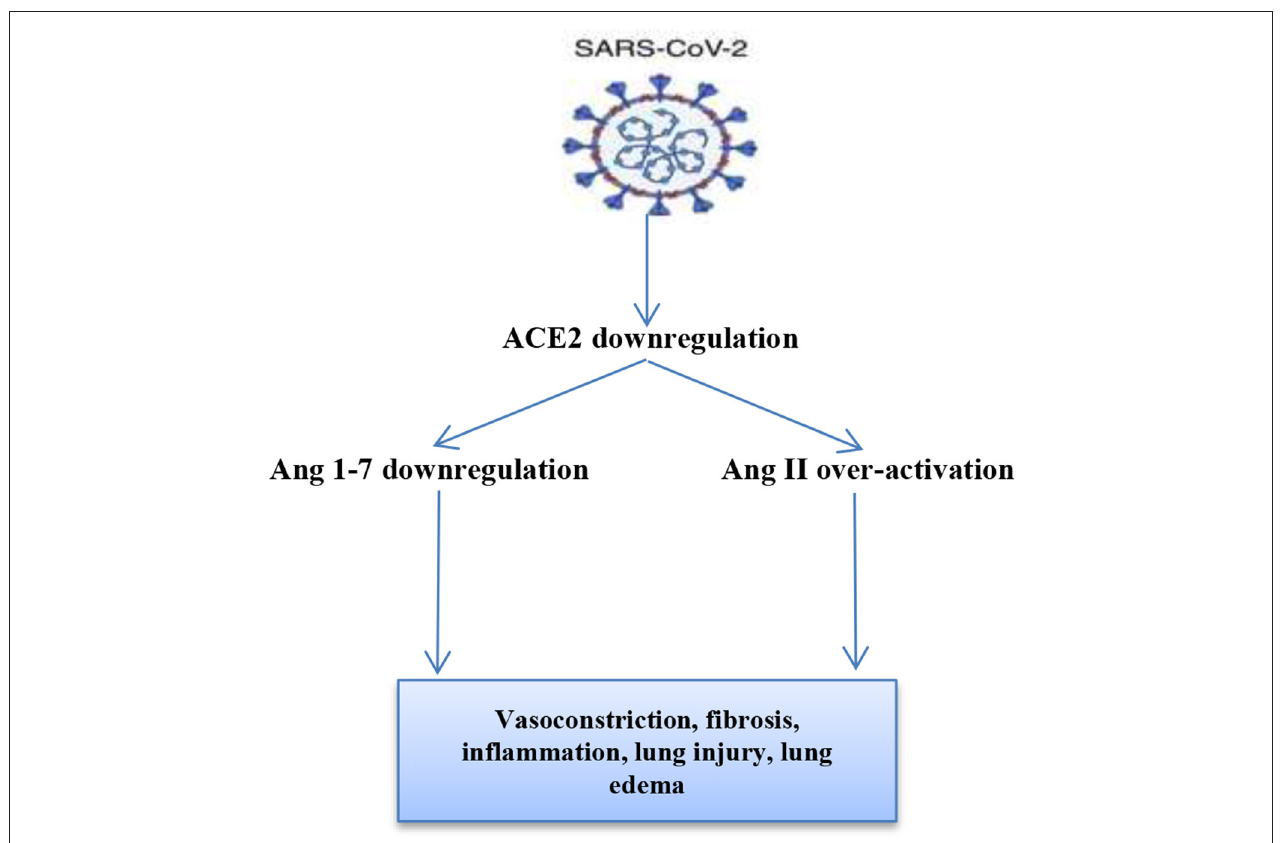
FIGURE 1 | SARS-CoV-2 and renin-angiotensin system (RAS) interaction: SARS-CoV-2 down-regulates ACE2 leading to over-activation of AngII and reduction of Ang 1-7. Ang II through angiotensin receptor type 1 (AT1R) leads to lung injury, inflammation, and vasoconstriction. Ang 1-7 through Mas receptor leads to vasodilation and lung